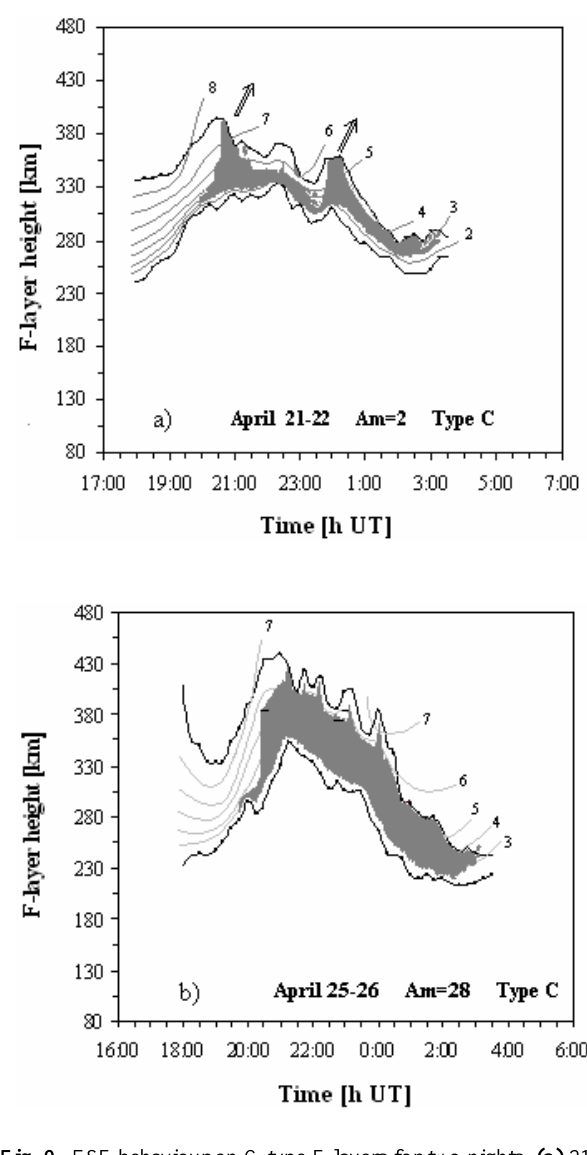
Fig. 9. ESF behaviour on C-type F-layers for two nights, (a) 21– 22 April and (b) 25–26 April. The b-type trace is similarly thin in both nights indicating no influence of the magnetic activity on the Rayleigh-Taylor phenomenon. In contrast the I-type trace is thicker in disturbed nights (Fig. 9b) than in quiet nights (Fig.